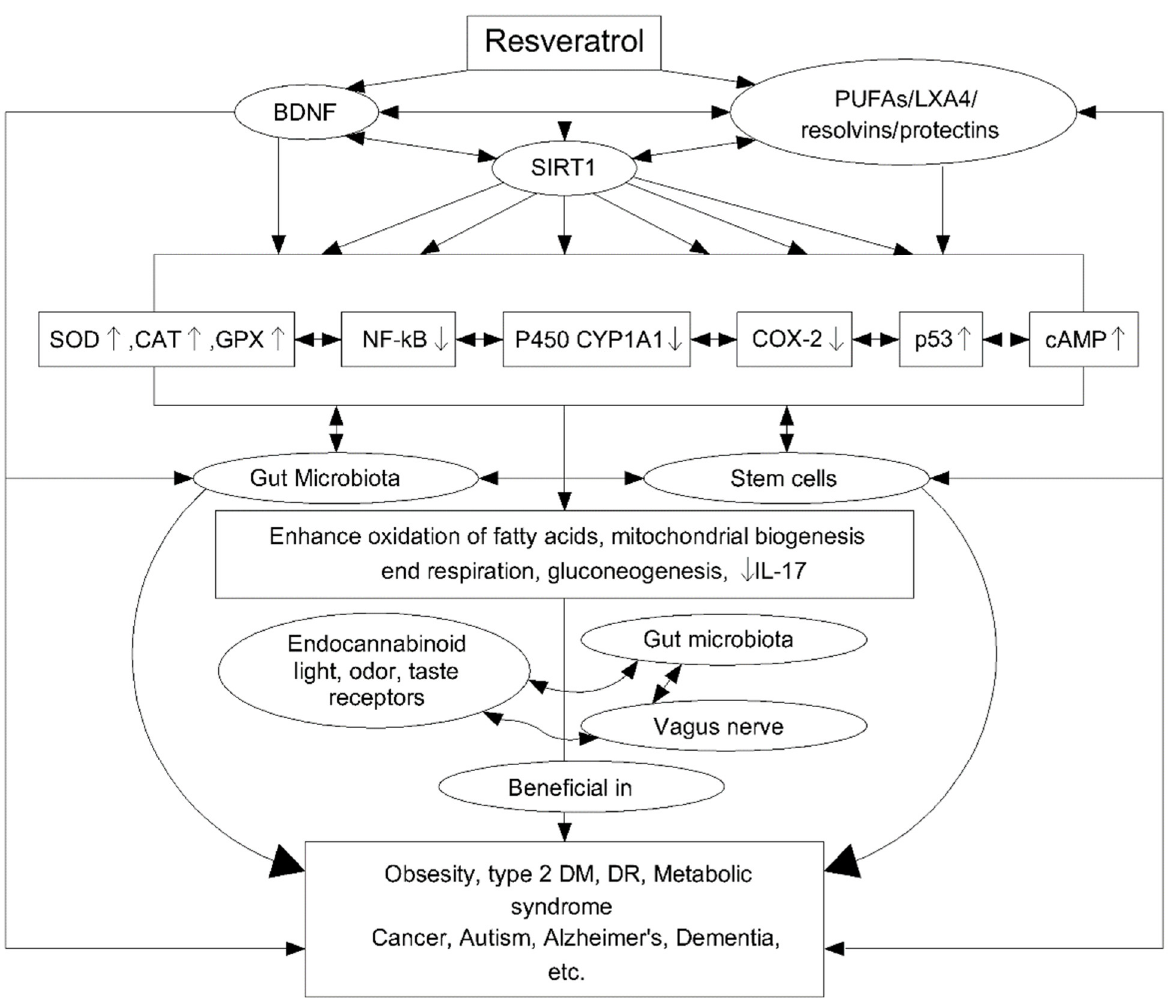
Figure 7. Scheme of resveratrol (Res) cellular action and its further impact. Reprinted and adapted with permission from Ref. [127]. Copyright (2020) Elsevier.